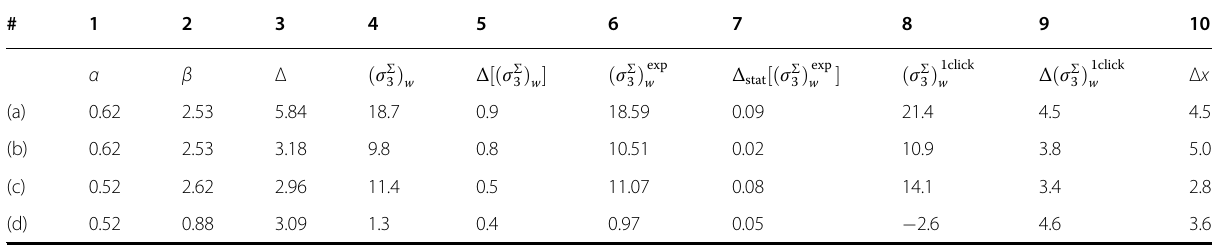
Table 1 Results for the various parameters of the measurement setup